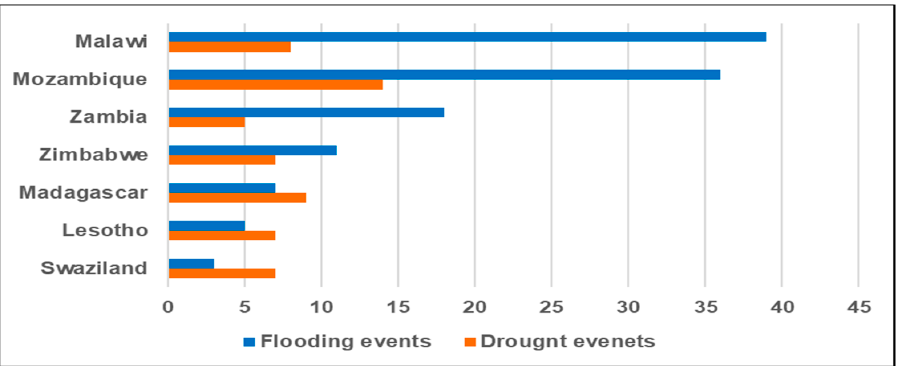
Figure 5. Drought and flooding events in selected Southern Africa countries from 1960 to 2018. Source: Graph plotted from data obtained from the International Disaster Database. Data used with permission from Guha-Sapir, EM-DAT (The International Disaster Database, Centre for Research on the Epidemiology of Disasters (CRED); published by Université Catholique de Louvain: Brussels, Belgium, 2020.